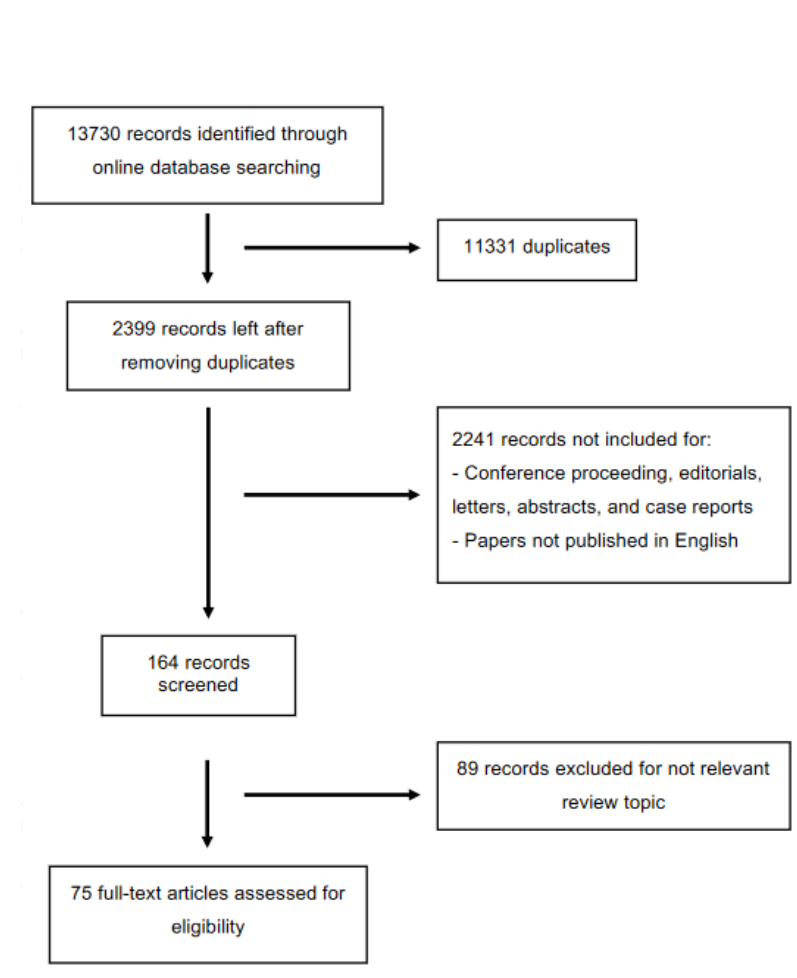
Figure 1. Flow chart of the study selection.